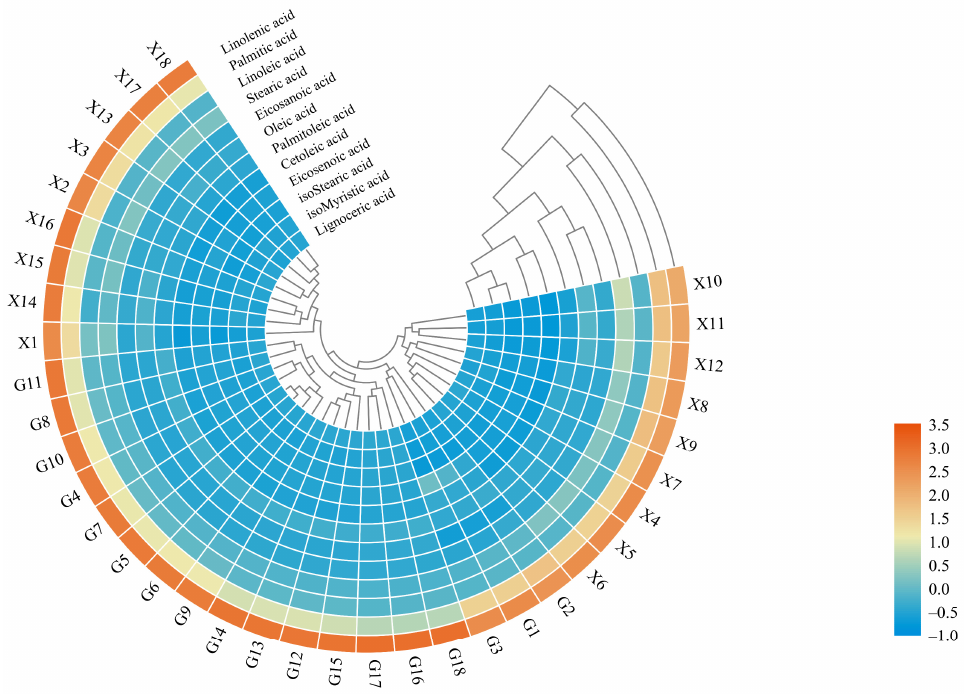
Figure 2. Cluster heat map (CHM) analysis of fatty acid composition for two varieties of FG and FX samples under 4 ◦ C cold stress. G denotes the cold-tolerant cultivar “Fuguhuajiao” and X denotes the cold-sensitive cultivar